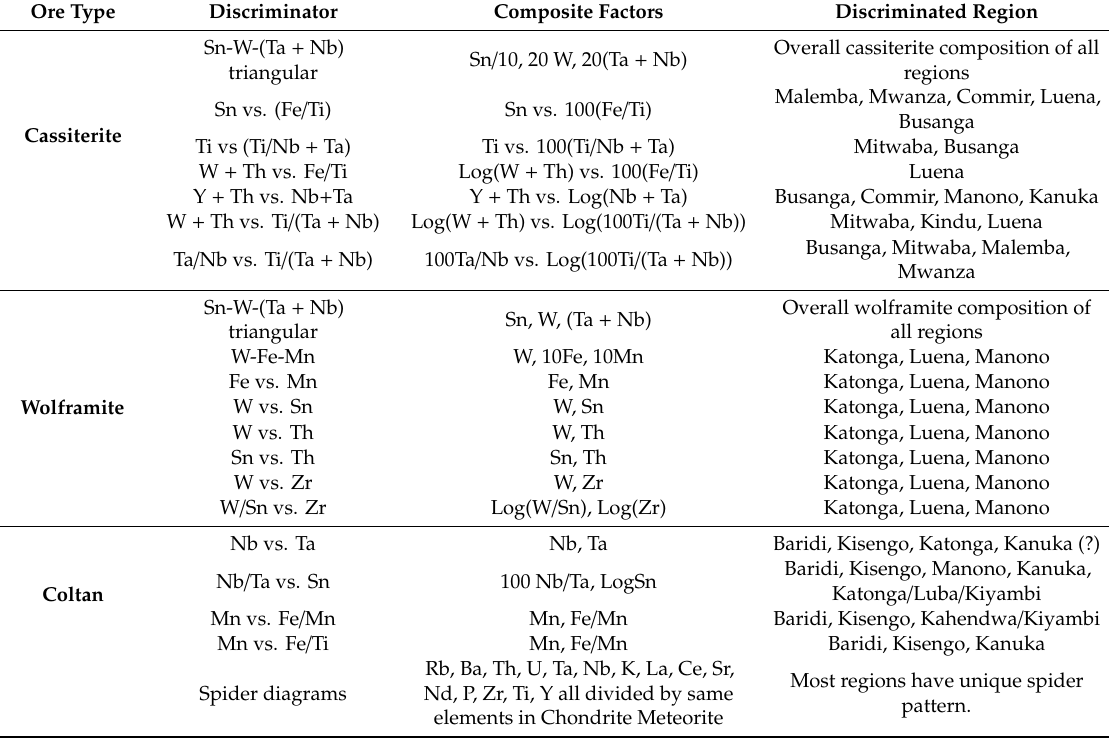
Table 8. Discriminators that are used for fingerprinting conflict